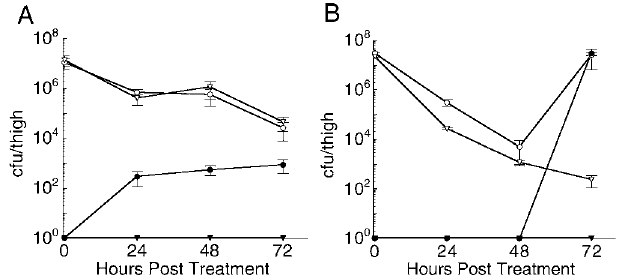
Figure 1. Survival and Mutation of E. coli Mutants In Vivo after Starting Antibiotic Therapy Survival and mutation of D lacZ and lexA (S119A) mutants of E. coli ATCC 25922 in thighs of neutropenic mice at 24-h intervals after starting therapy with (A) ciprofoxacin or (B) rifampicin. Open circles and triangles correspond to the total cfu/thigh of the D lacZ and lexA (S119A) strains, respectively. Solid circles and triangles represent the number of drug-resistant D lacZ and lexA (S119A) cfu/thigh, respectively. DOI: 10.1371/journal.pbio.0030176.g001